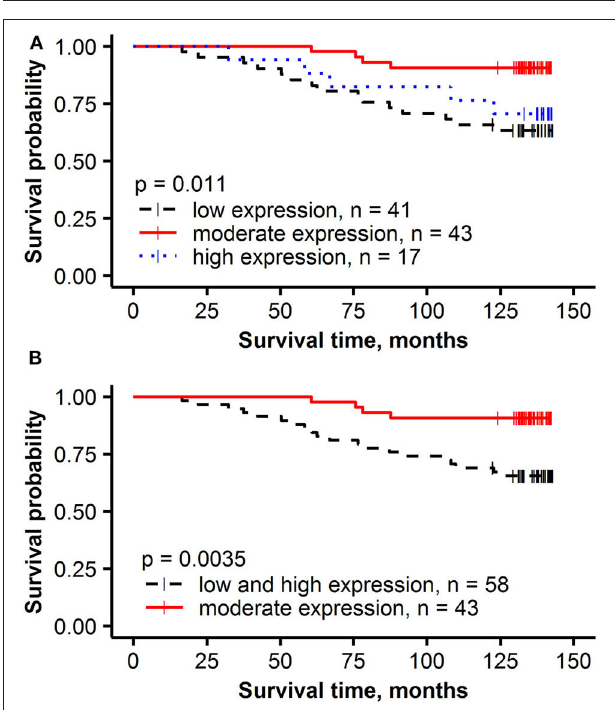
FIGURE 5 | Kaplan-Meier survival plots with hazard ratio and log-rank test for correlation of PR% groups with overall survival: (A) low expression ( < 20%), moderate expression (20–80%) and high expression (higher than 80%), (B) low and high expression ( < 20% or higher than 80%) and moderate expression